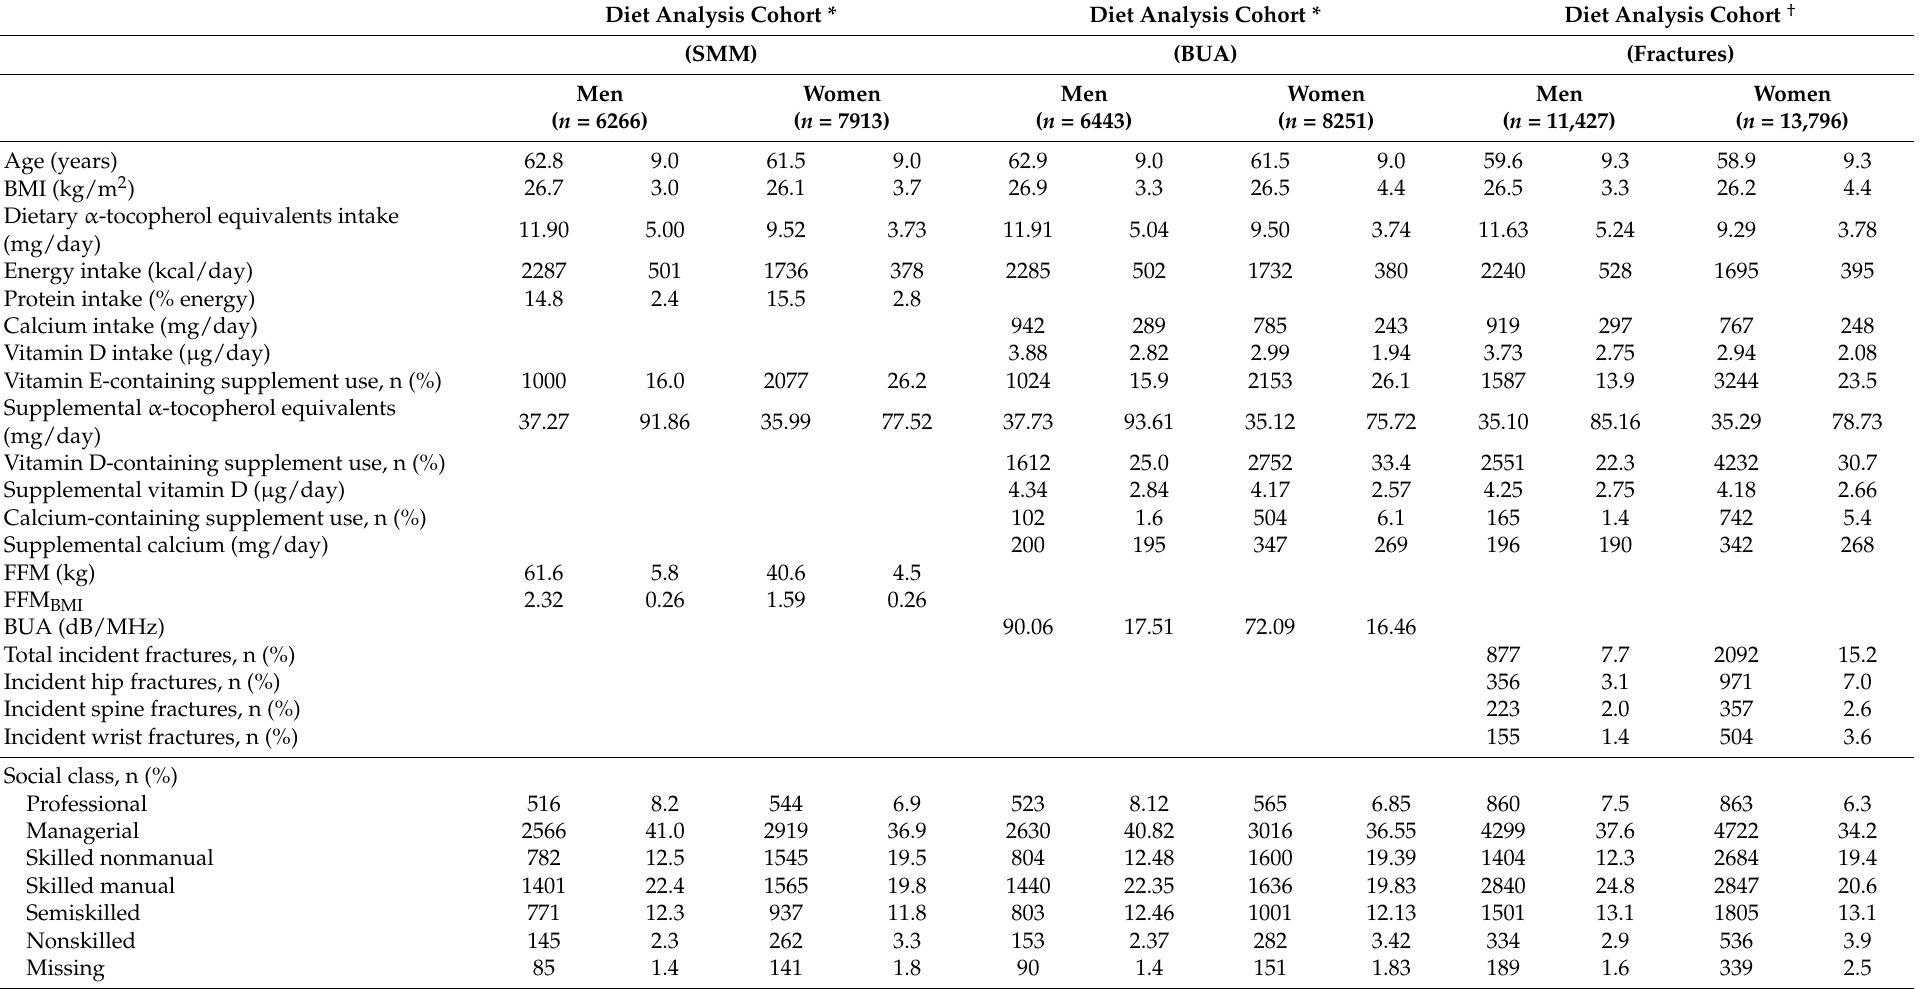
Table 1. Selected characteristics of the European Prospective Investigation Into Cancer and Nutrition (EPIC)-Norfolk cohort population, stratified by sex and diet analysis